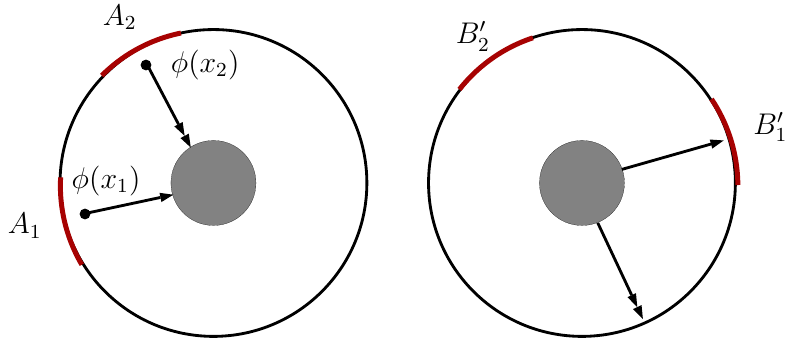
Figure 5 . In this example, a signal sent from the boundary subregion A subregion B 0 , but a signal sent from A 2 reaches no receiving B 0 1